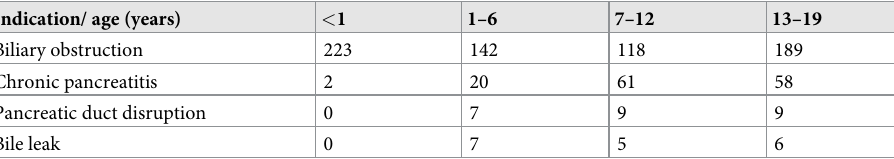
Table 1. The indications for ERCP stratified by